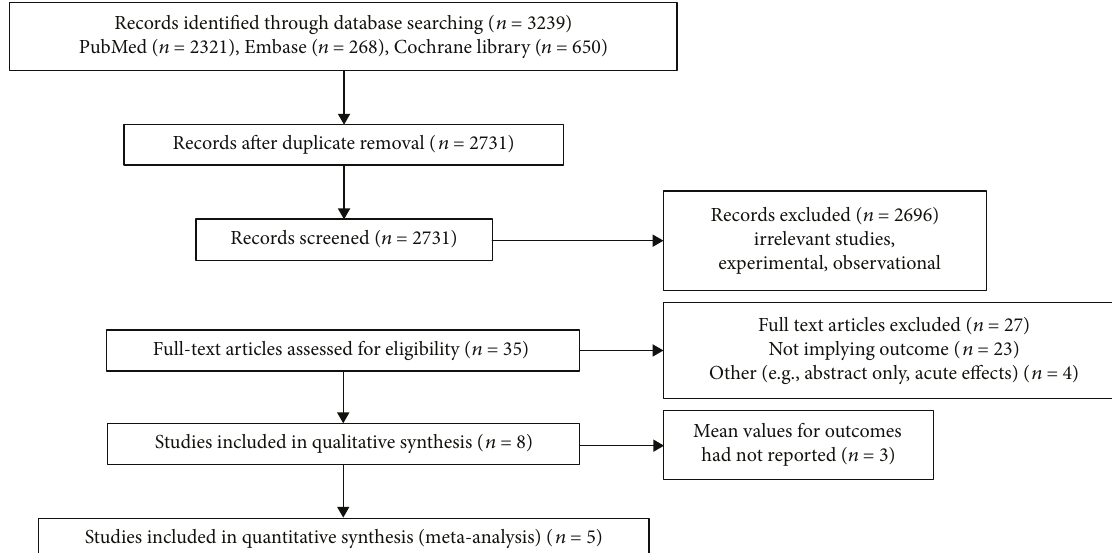
Figure 1: Flow diagram of the